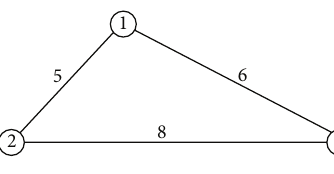
Figure 1: The network in the